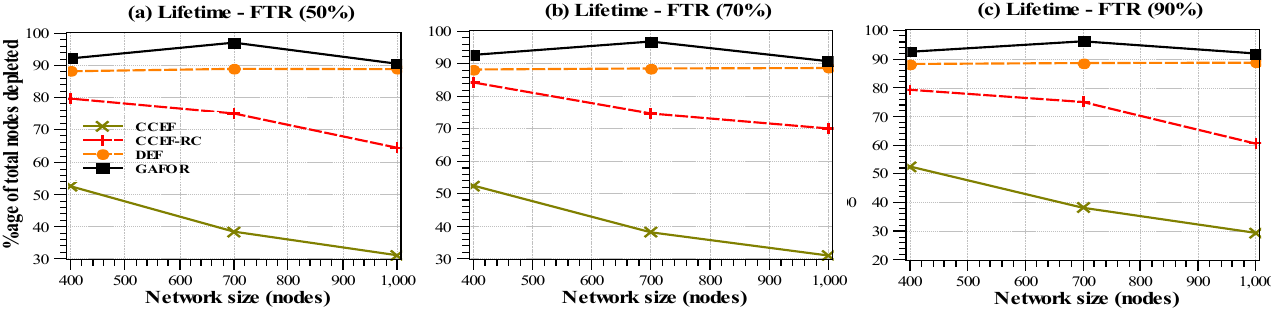
Figure 11. Network lifetime